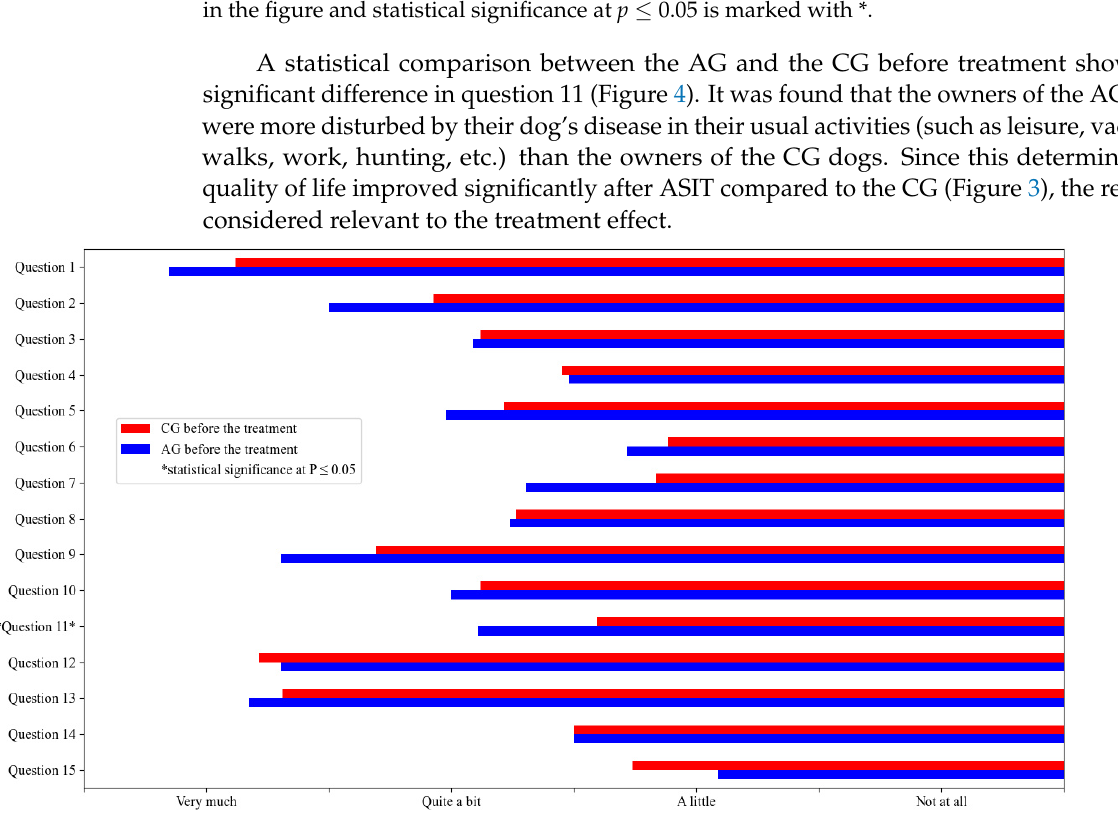
Figure 3. Statistical comparison of the quality of life of ASIT – treated dogs after the treatment (QoL2 AG) and dogs, not treated with ASIT, after the treatment (QoL2 CG). The mean values are repre- sented in the figure and statistical significance at p ≤ 0.05 is marked with * .